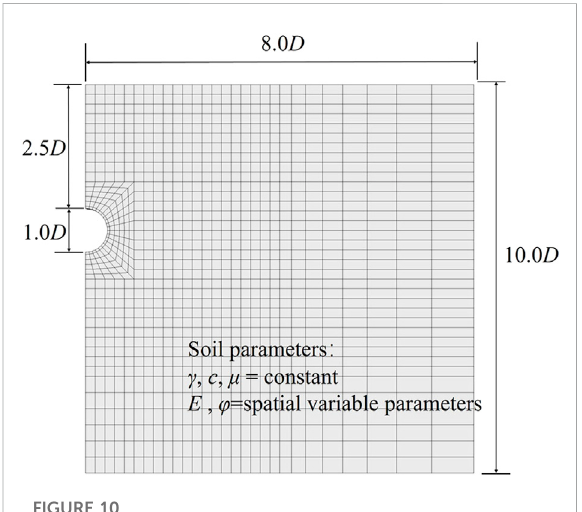
FIGURE 12 Veri fi cation of the ERVM by 100 random